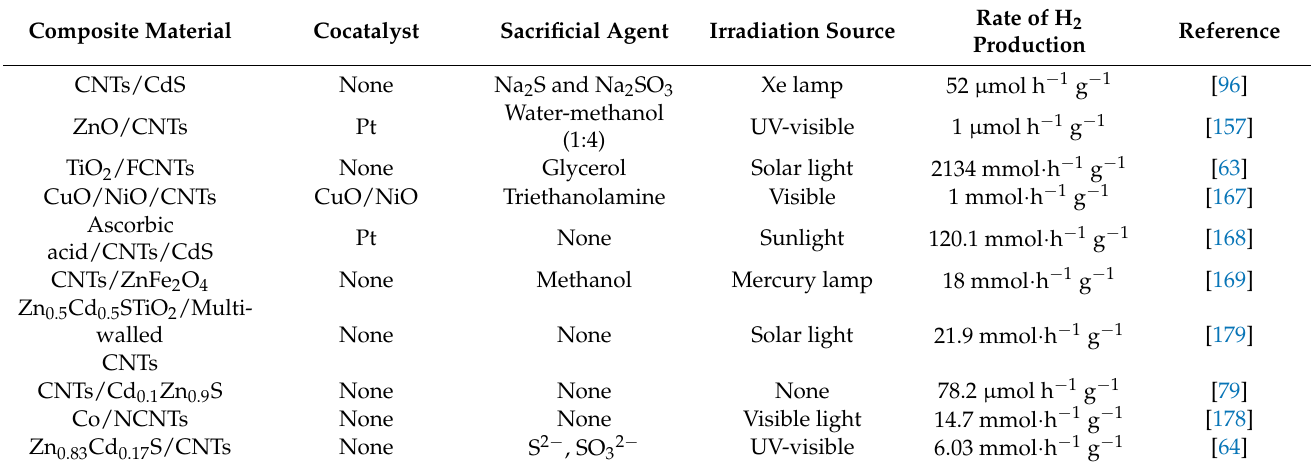
Table 4. Rate of H 2 production by CNT-based